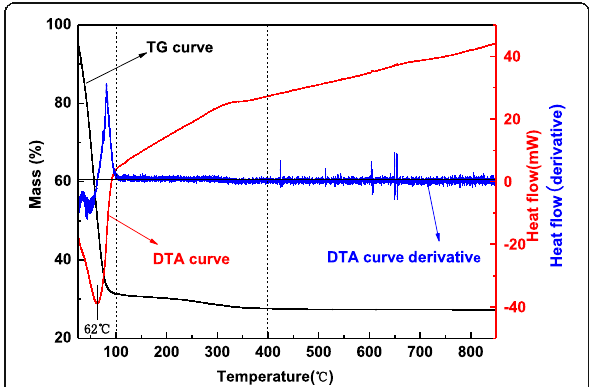
Fig. 2 TG/DTA graphs for zinc oxide